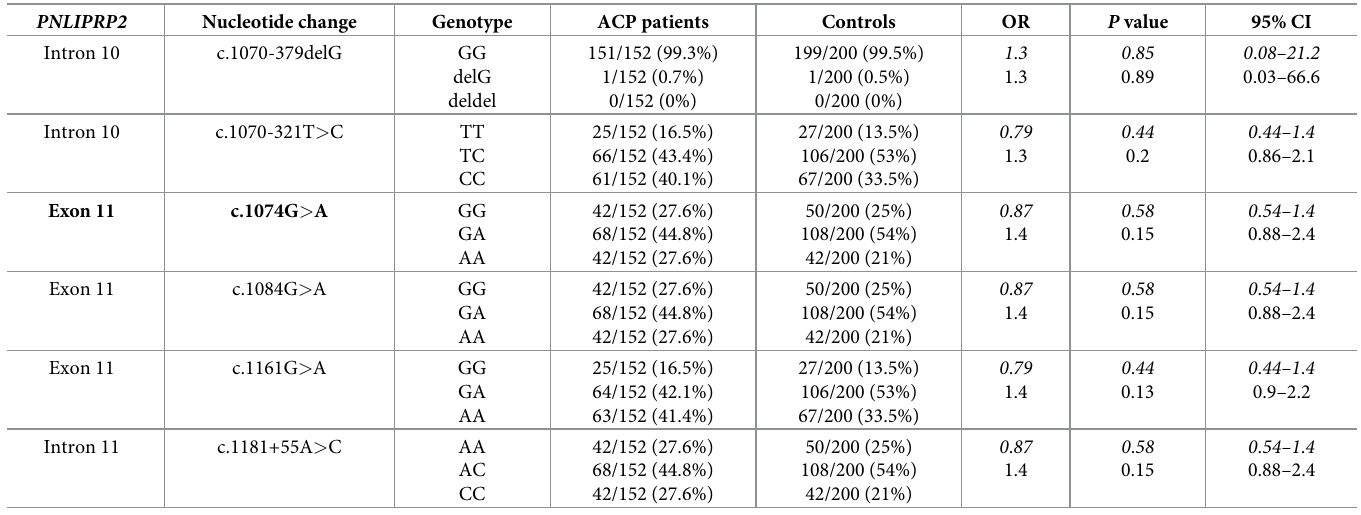
Table 9. Genotype distribution of PNLIPRP2 variants in patients with alcoholic chronic pancreatitis (ACP) and in controls.